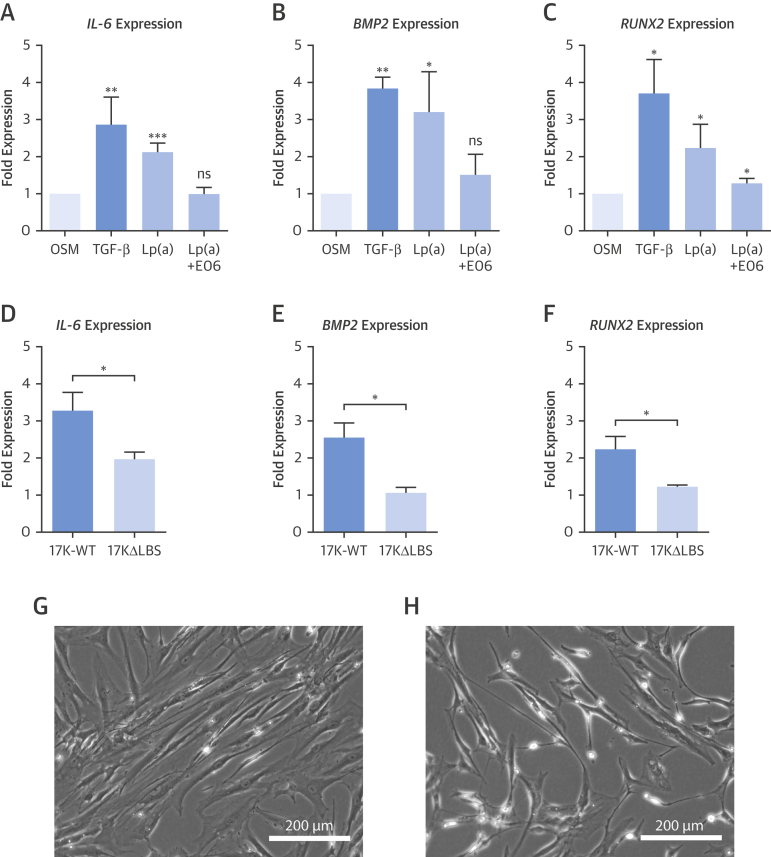
Lp(a) Induces Osteogenic Differentiation in VICs(A to C) VICs in osteogenic media only conditions were used as the baseline comparator, while addition of TGF-β served as a positive calcification control. One week of exposure to Lp(a) (100 mg/dl) induced gene expression of the inflammatory mediator IL-6 and osteoblastic regulators BMP2 and RUNX2. Pre-incubation with the E06 antibody targeting OxPL reduced the transcriptional effect of Lp(a), suggesting that OxPL is intrinsic to the pro-calcific effects of Lp(a). The role of OxPL was further validated using 2 r-apo(a) constructs that differ in their lysine binding sites and consequently their capacity to bind OxPL. (D to F) Three days of exposure to r-apo(a) 17K-WT construct induced increased expression of osteogenic genes. This effect was reduced with the 17KΔLBS10 construct that lacks the ability to bind OxPL. (G and H) Bright-field microscopy images of VICs after stimulation with 17K constructs. 17K-WT induces an activated, rhomboid shape, whereas 17KΔLBS10 was characterized by a quiescent, spindle-shaped morphology. Data represent mean ± SEM for at least n = 3 independent experiments. *p < 0.05; **p < 0.01; ***p < 0.001 compared with OSM only or comparison between 17K-WT and 17KΔLBS10. 17K-WT = 17 kringles wild-type r-apo(a) construct; 17KΔLBS = 17K r-apo(a) construct without lysine binding site; BMP2 = bone morphogenetic protein 2; E06 = E06 monoclonal antibody; IL-6 = interleukin-6; OSM = osteogenic medium; RUNX2 = Runt-related transcription factor 2; TGF-β = transforming growth factor beta. VIC = valvular interstitial cell.